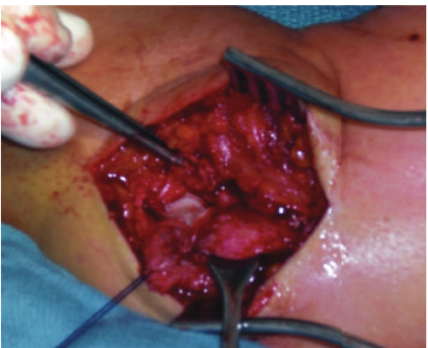
Figure 4: Isolated rupture of the lateral ulnar collateral ligament (LUCL) resulting in persistent posterolateral rotational instability (PLRI) in a patient who works as an anesthesiologist. She was not able to retract the speculum after trauma. The picture illustrates the intraoperative reconstruction of the proximal torn